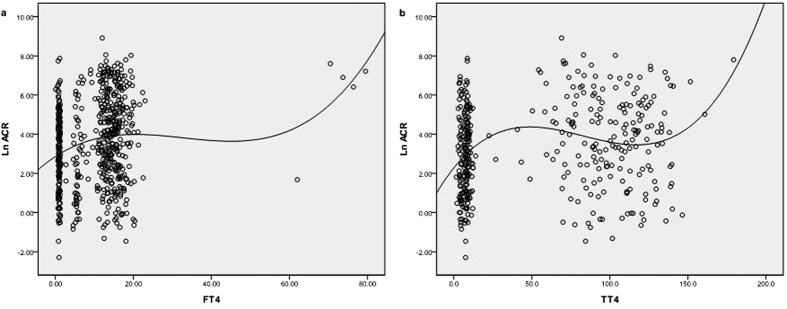
The scatterplot of FT4 and TT4 associated with Ln ACR.Smoothed line shows the fit of the dat. FT4: free T4 (pmol/L); TT4: total T4 (mmol/L); Ln ACR: urinary albumin to creatinine ratio by natural logarithm transformed.